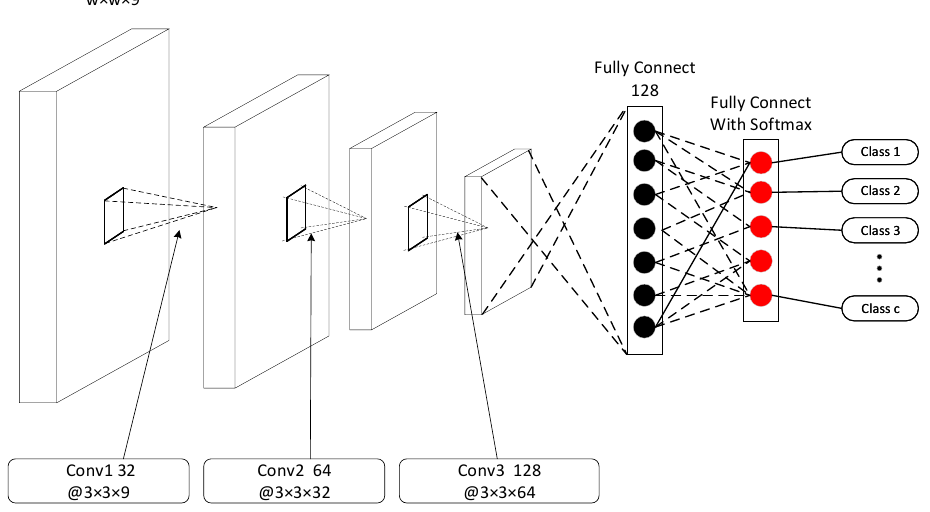
Figure 2. Network architecture of the SCNN